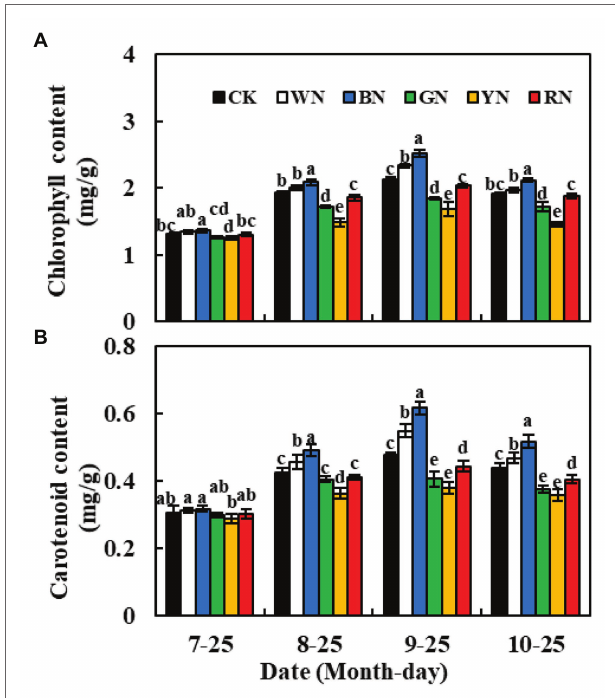
FIGURE 3 | Effect of photo-selective nets on the photosynthetic pigment contents of green onion leaves at different growth stages. (A) Chlorophyll content, (B) carotenoid content. CK, control; WN, white photo-selective nets; BN, blue; GN, green; YN, yellow; and RN, red. Values are average ± SD, n = 18. Error bars indicate standard errors. Different letters (a, b, c, d, and e) in the same column indicate significant differences among treatments at p ≤ 0.05 according to Duncan’s new multiple range